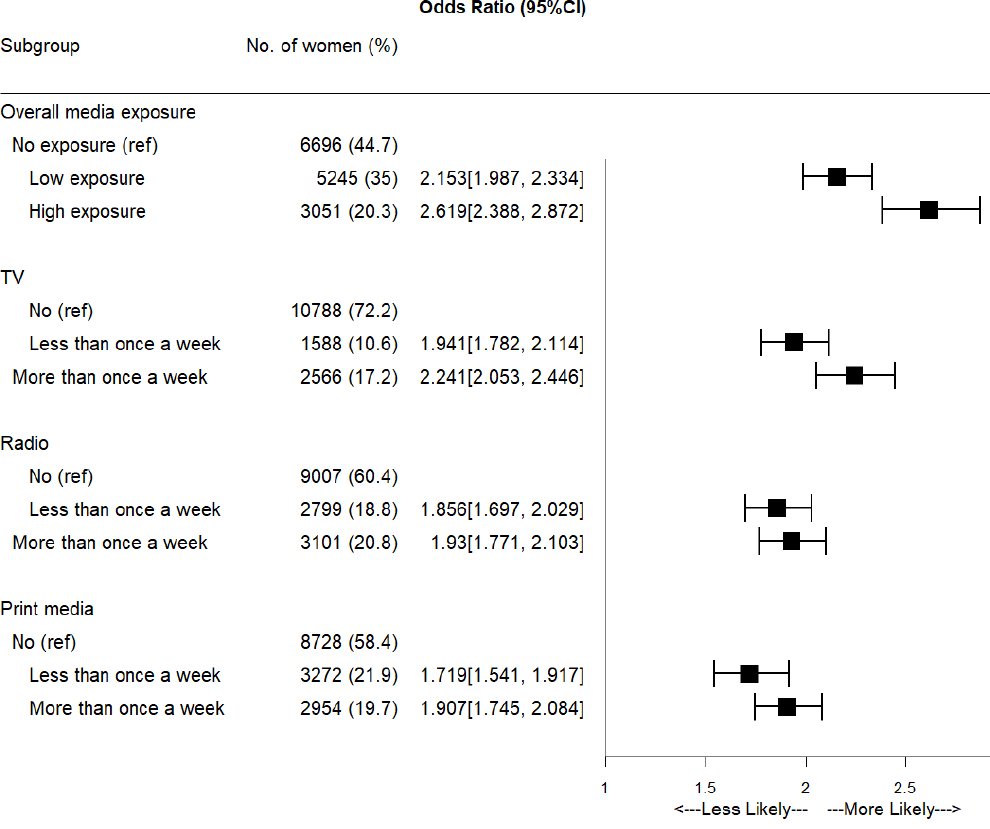
Figure 2. Forest plot showing the impacts of different media exposure on HIV testing. We also present the adjusted odds ratio of HIV testing while controlling for other covariates which may potentially confound the results. For example, after controlling for other covariates in the multivariable model, the effects of media exposure was still significantly high (Table 4). Women with increased media exposure were more likely to have had an HIV test (aOR = 1.53, 95% CI: 1.36, 1.72) compared to women with no media exposure. We also found a higher level of education was significantly associated with increased odds of HIV testing, and the odds were highest for women with more than secondary education (aOR = 3.38, 95% CI: 2.57, 4.46). Higher household wealth quintiles and condom use were associated with HIV testing, while marital status, knowledge of transmission and religion were not associated with HIV testing (Table 4). Table 4. Association between exposure to media and HIV testing and other